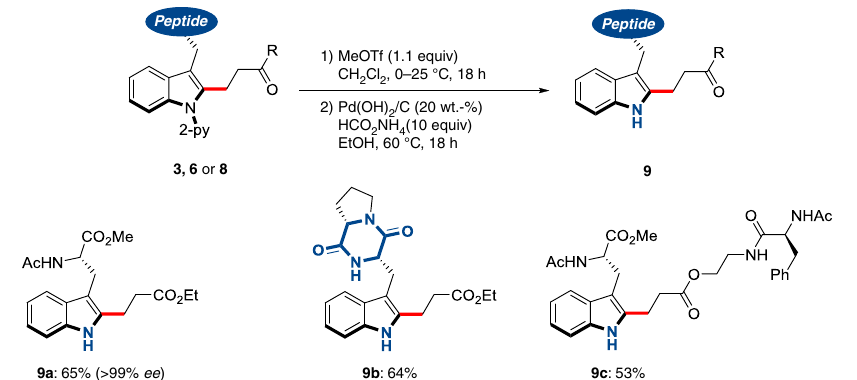
Fig. 6 Expedient access to functionalized NH-free tryptophan-containing peptides. Traceless removal of the pyridine group under